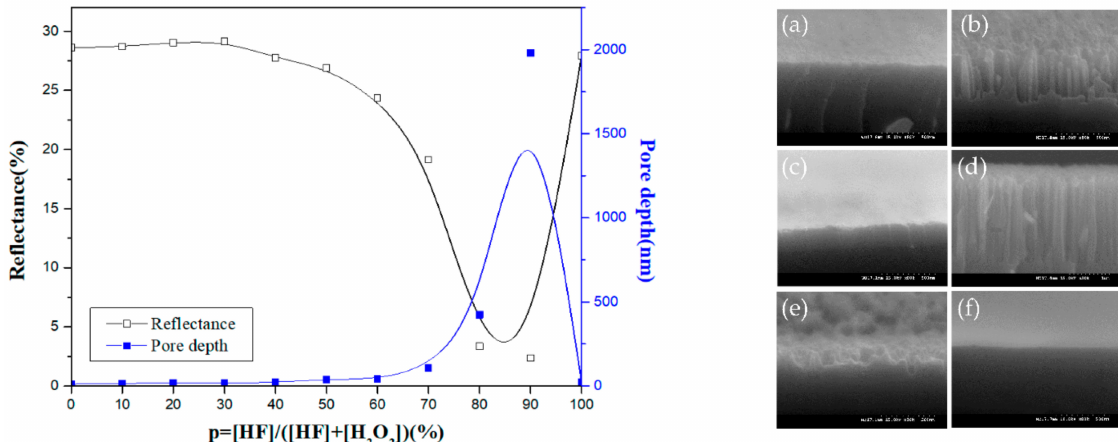
Figure 6. Reflectance and cross-section SEM images of wafer surfaces according to mole fraction ( ρ ) for the MACE process: ( a ) ρ 50%, ( b ) ρ 60%, ( c ) ρ 70%, ( d ) ρ 80%, ( e ) ρ 90%, and ( f ) ρ